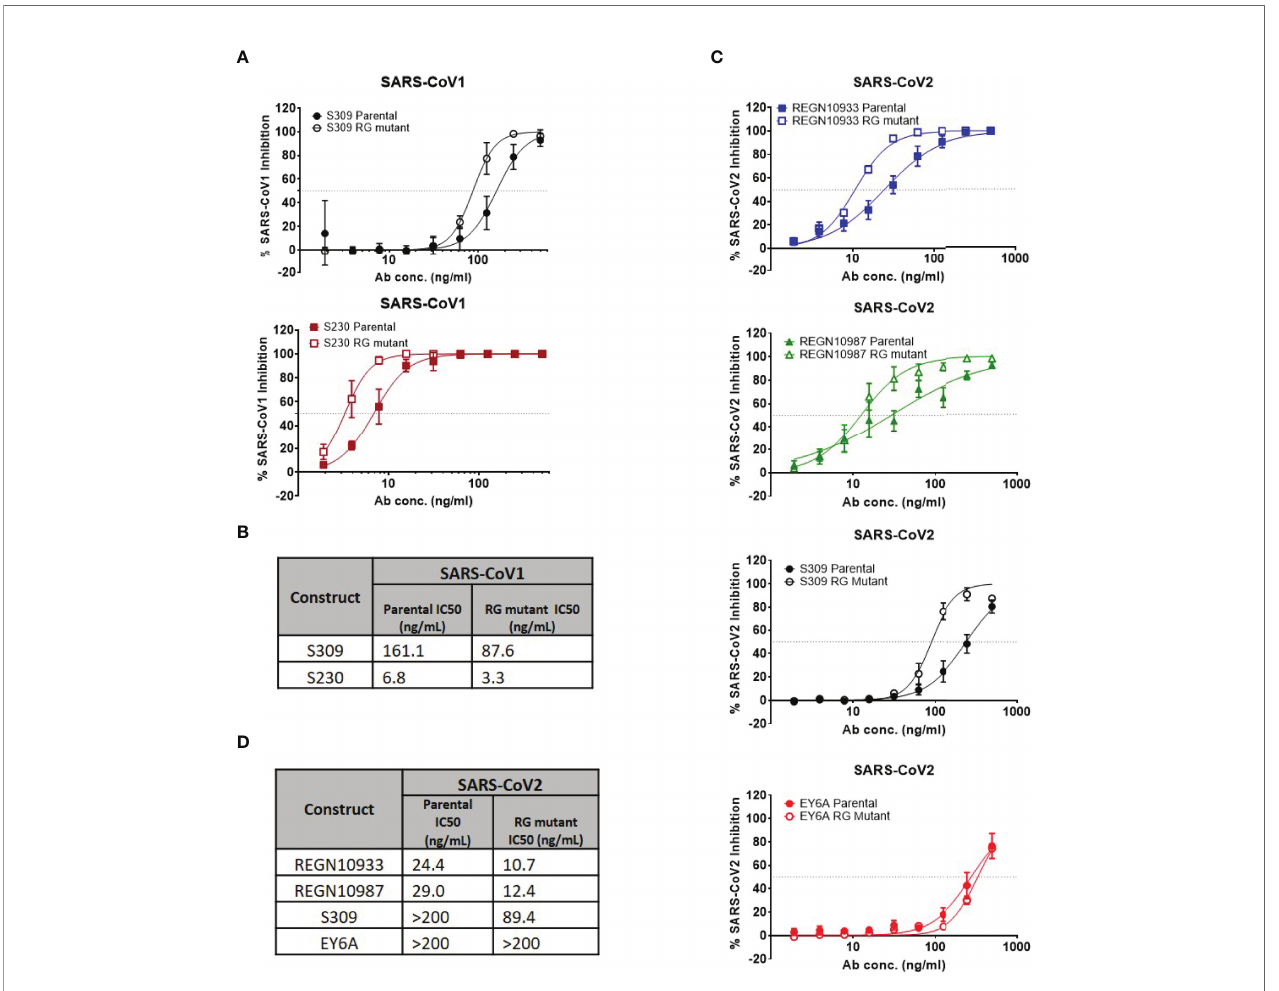
FIGURE 3 | Authentic (live) virus neutralization assays for SARS-CoV-1 and SARS-CoV-2. (A) Percent SARS-CoV-1 neutralization with select antibodies (mean values with SEM; n = 4). (B) Calculated IC 50 neutralization values for SARS-CoV-1. (C) Percent SARS-CoV-2 neutralization with select antibodies (mean values with SEM; n = 4). (D) Calculated IC 50 neutralization values for SARS-CoV-1. Data for non-neutralizing constructs may be found in the Supplemental information ( SI Figure 3